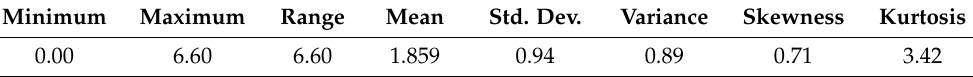
Table B7. Statistics of the atmospheric pressure distribution [Pa].